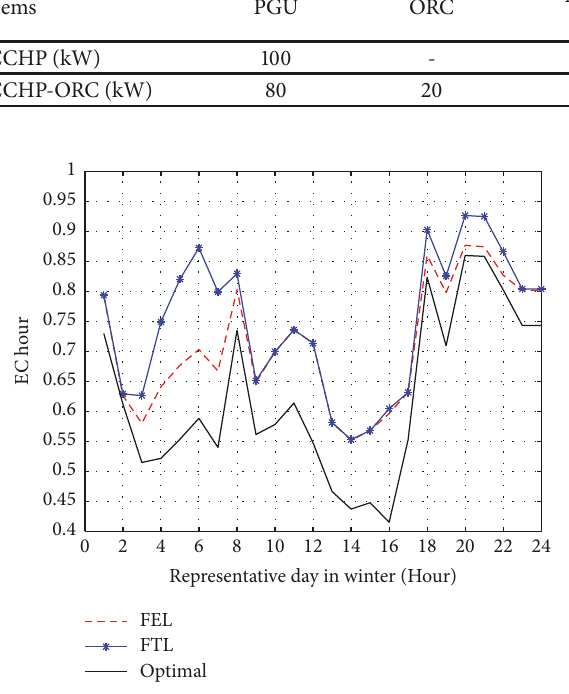
Figure 10: Comparison of three strategies in a winter day.